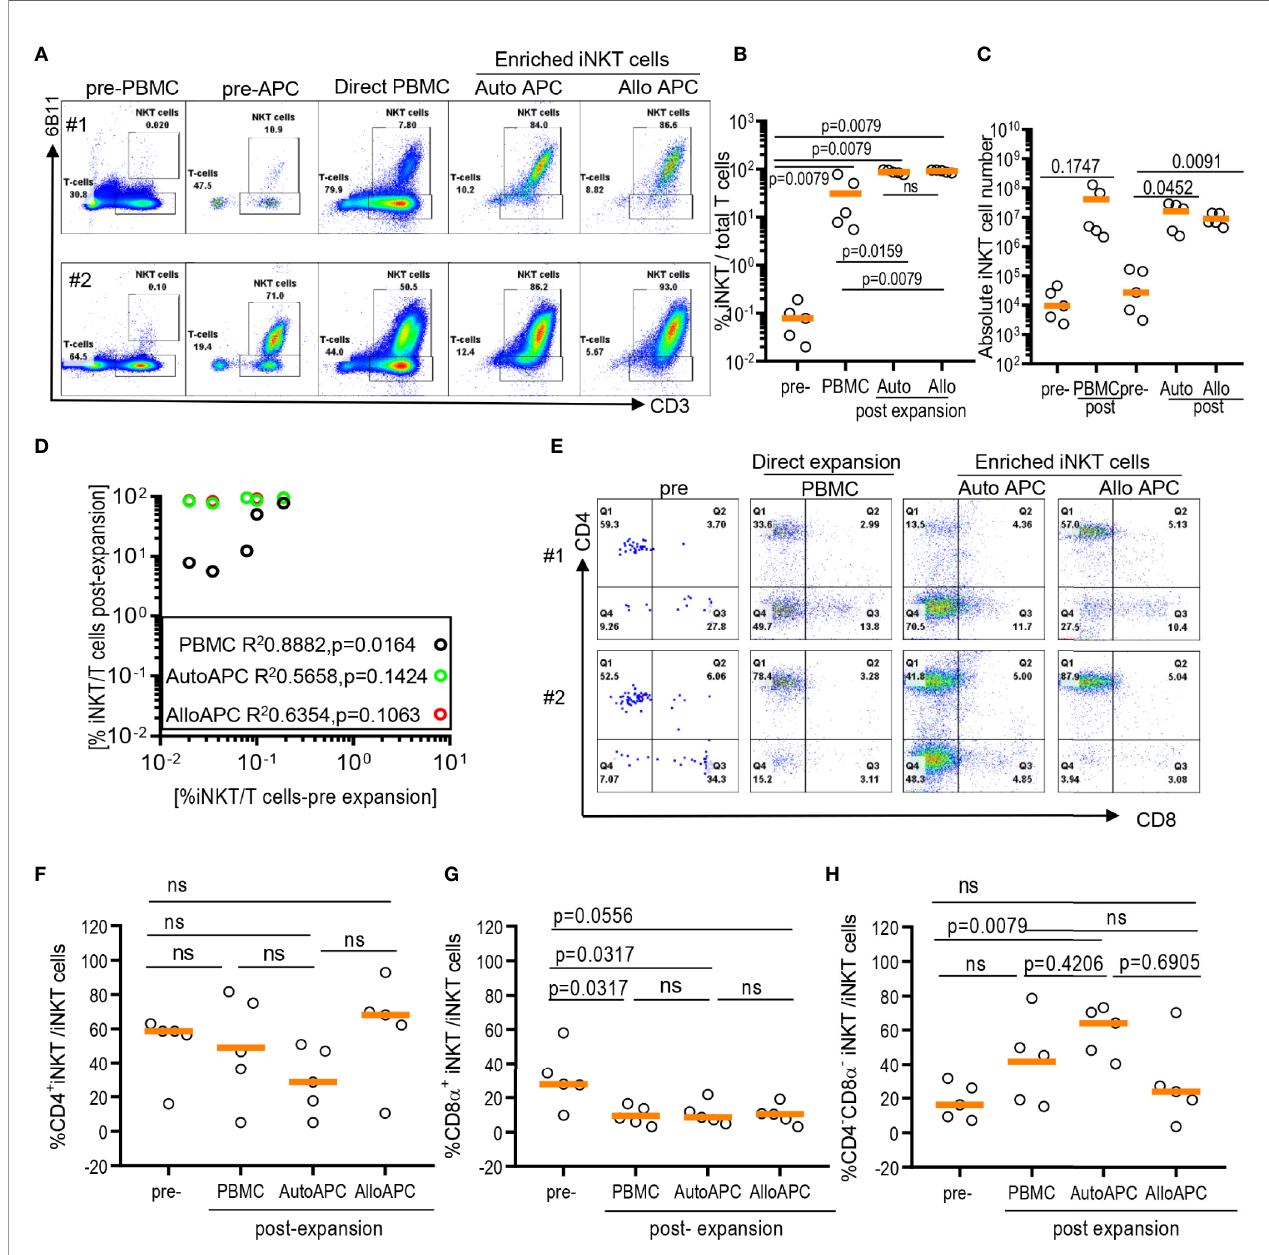
FIGURE 2 | Expansion of enriched iNKT cells via antigenic stimulation using a GalCer pulsed irradiated autologous peripheral blood mononuclear cells (PBMCs) and allogeneic dendritic cell (DC). The iNKT cells were enriched from fi ve healthy donors and co-cultured with irradiated autologous PBMCs or allogeneic DC in the presence of a GalCer and IL-2 for 10 days. As a control, a GalCer and IL-2 were directly added to PBMCs. (A) The representative fl ow cytometric analyses of iNKT cells pre and post expansion from two donors. (B) Percentage of iNKT cells from total T cells at each step from fi ve donors. (C) Absolute numbers in pre- and post- expansion from direct antigenic stimulation of iNKT cells from PBMCs and autologous and allogenic DCs. (D) Linear regression showing the correlation between the percentage of pre and post of iNKT cells in healthy donor samples. (E – H) The percentage of CD4 + , CD8 a + and CD4 - CD8 a - iNKT cells pre and post expansion. A paired t test was used to compare the differences between selected